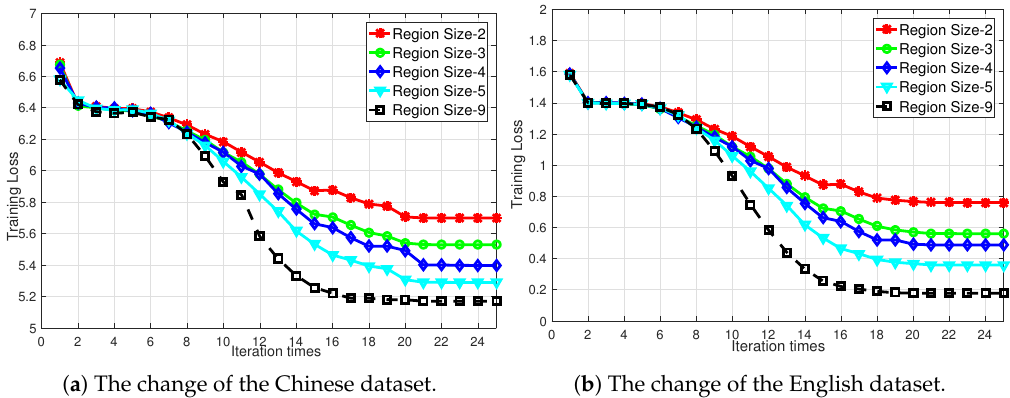
Figure 9. Training loss curve along with the change of the region size of the